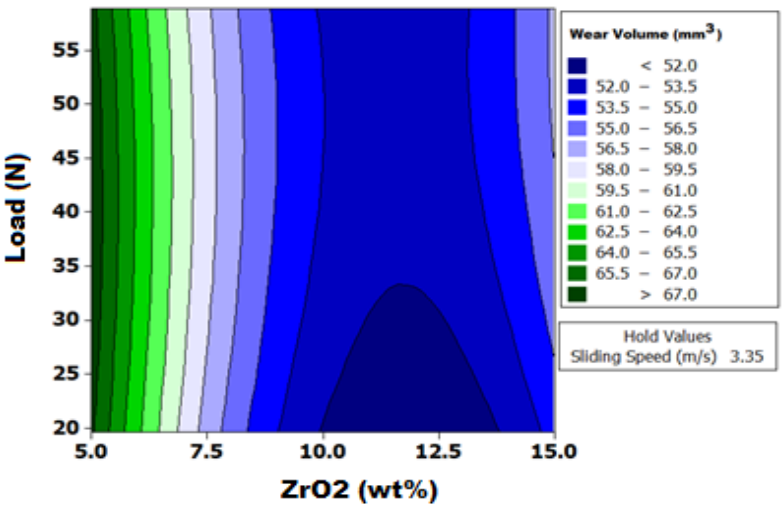
Table 9. Analysis of variance for S/N ratio.